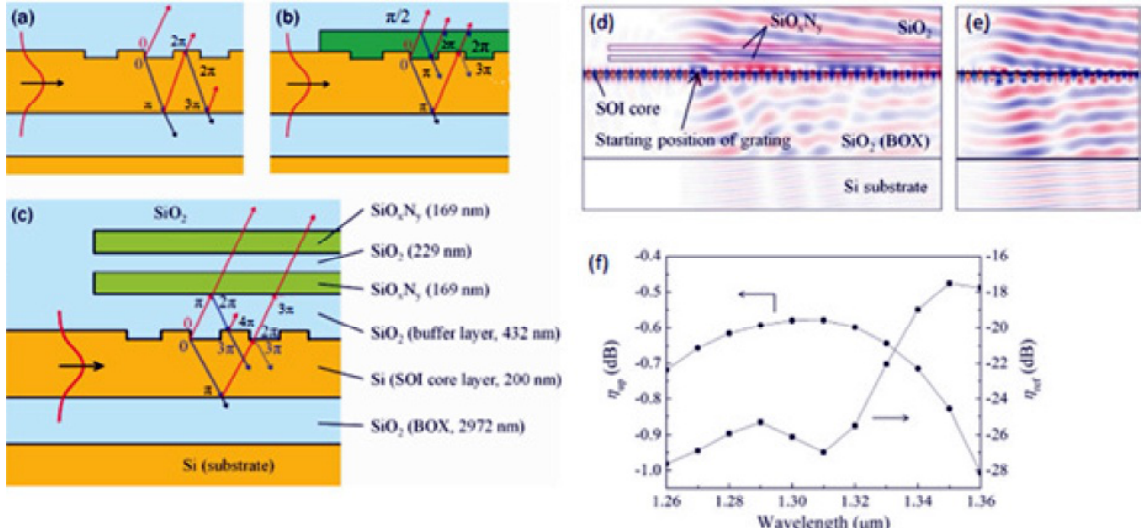
Fig. 9. Cross-sections for (a) a single-layer grating (b) a double-layer grating, and (c) a quadruple-layer grating of ARC. The upward and downward propagating lights were respectively represented by the red and blue arrows. The lights have relative phases at the layer interfaces. The transverse electric field spreading of light distributing in and out of gratings (d) with a quadruple ARC and (e) without a quadruple ARC. (f) Presents the wavelength dependence of upward directionality (solid circle) and back reflection along the waveguide (solid square) with a quadruple ARC. Reprinted with permission from M. Tokushima, J. Ushida, T. Uemura and K. Kurata // Applied Physics Express 8 (2015)